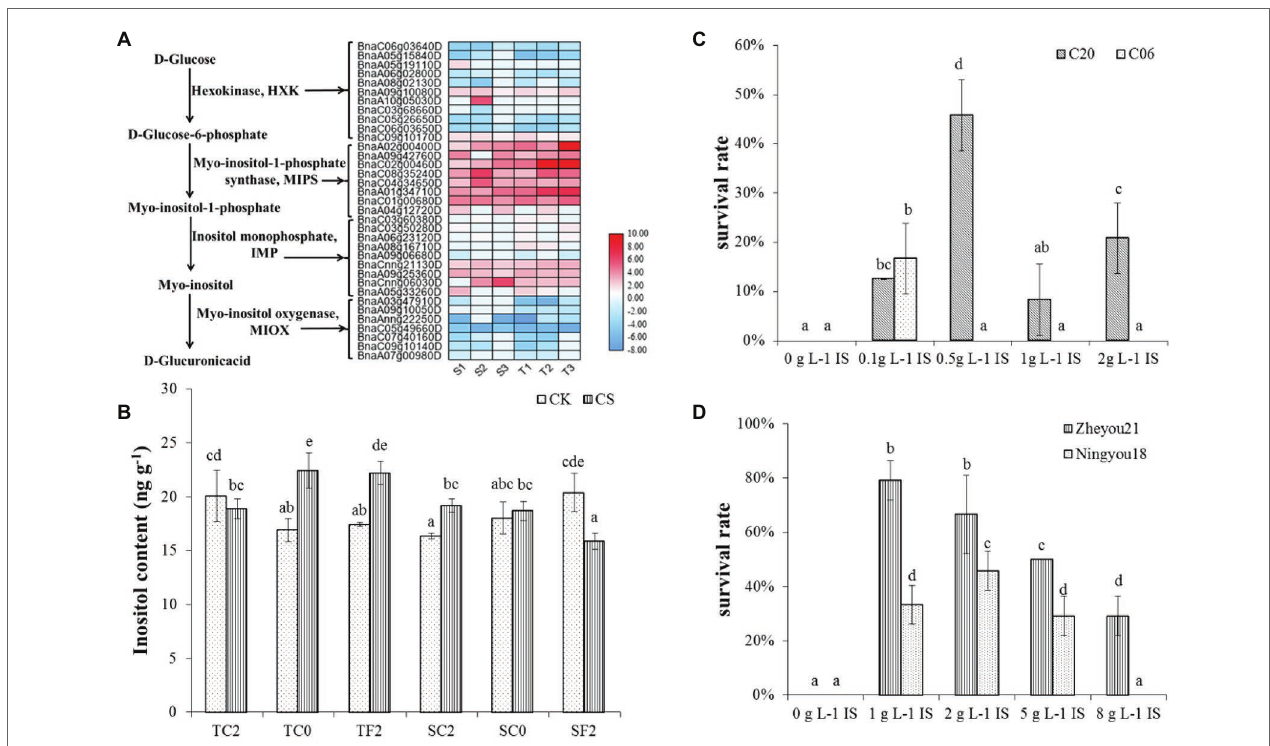
FIGURE 2 | Inositol involved in cold tolerance in rapeseed. (A) The expression analysis of DEGs involved inositol biosynthesis and degradation. Heat map data is log2 (Fold change). T1: the tolerant variety C18 under 2 ° C compared to corresponding control; T2: C18 under 0 ° C compared to corresponding control; T3: C18 under − 2 ° C compared to corresponding control; S1: the sensitive variety C20 under 2 ° C compared to corresponding control; S2: C20 under 0 ° C compared to corresponding control; S3: C20 under − 2 ° C compared to corresponding control. (B) Endogenous inositol concentrations under different cold treatment. TC2: C18 under 2 ° C; TC0: C18 under 0 ° C; TF2: C18 under − 2 ° C; SC2: C20 under 2 ° C; SC0: C20 under 0 ° C; SF2: C20 under − 2 ° C; CS: cold stress; CK: 22 ° C. Values were means of three replications, and the bars were represented the standard error of means. Different letters were represented significant differences according